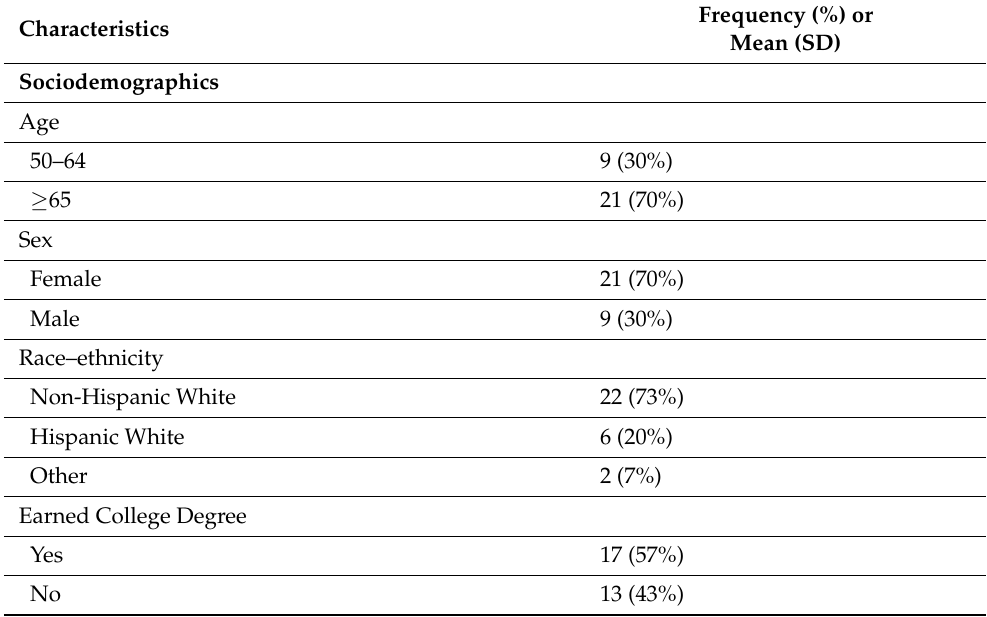
Table 1. Baseline characteristics of cancer survivors participating in the home-based, vegetable gardening study during the COVID-19